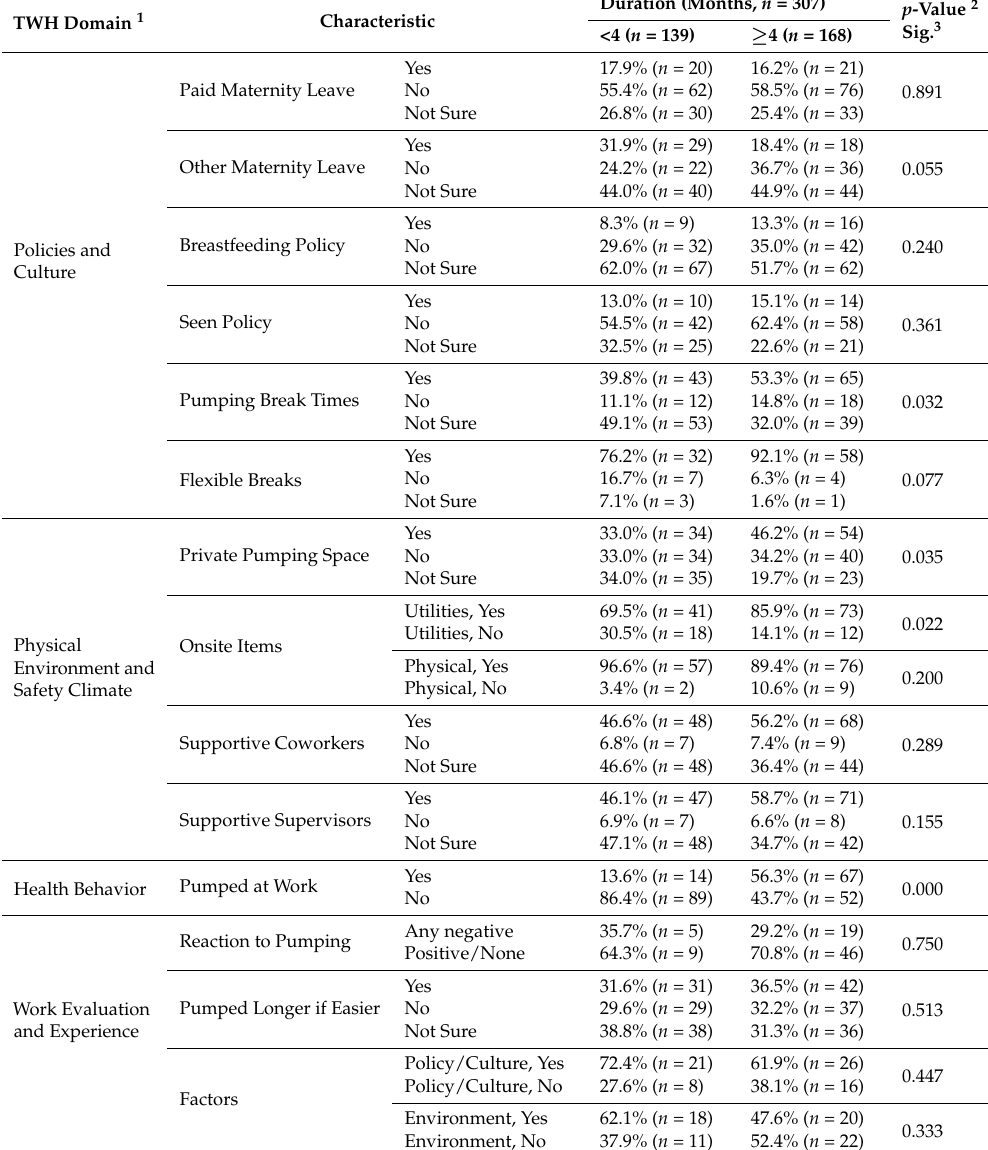
Table 4. Maternal Workplace Characteristics by Duration of Breastfeeding (<4 Months Versus ≥ 4